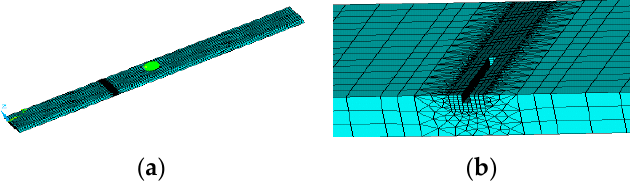
Figure 3. Overall ( a ) and local ( b ) finite element model of cracked beam and lead–zirconate–titanate (PZT) patch.